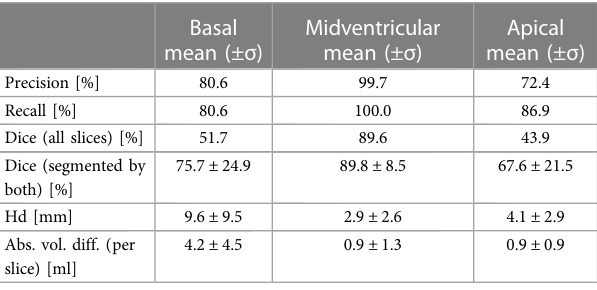
TABLE 2 Intraclass correlation. TABLE 4 Overall segmentation accuracy by slice position.